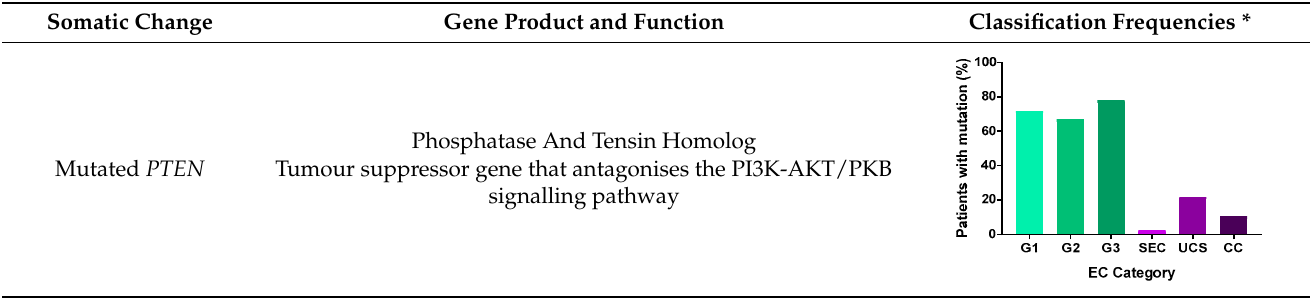
Table 3. Major driver genes used in the classification of endometrial carcinomas and their somatic frequencies. Somatic Change